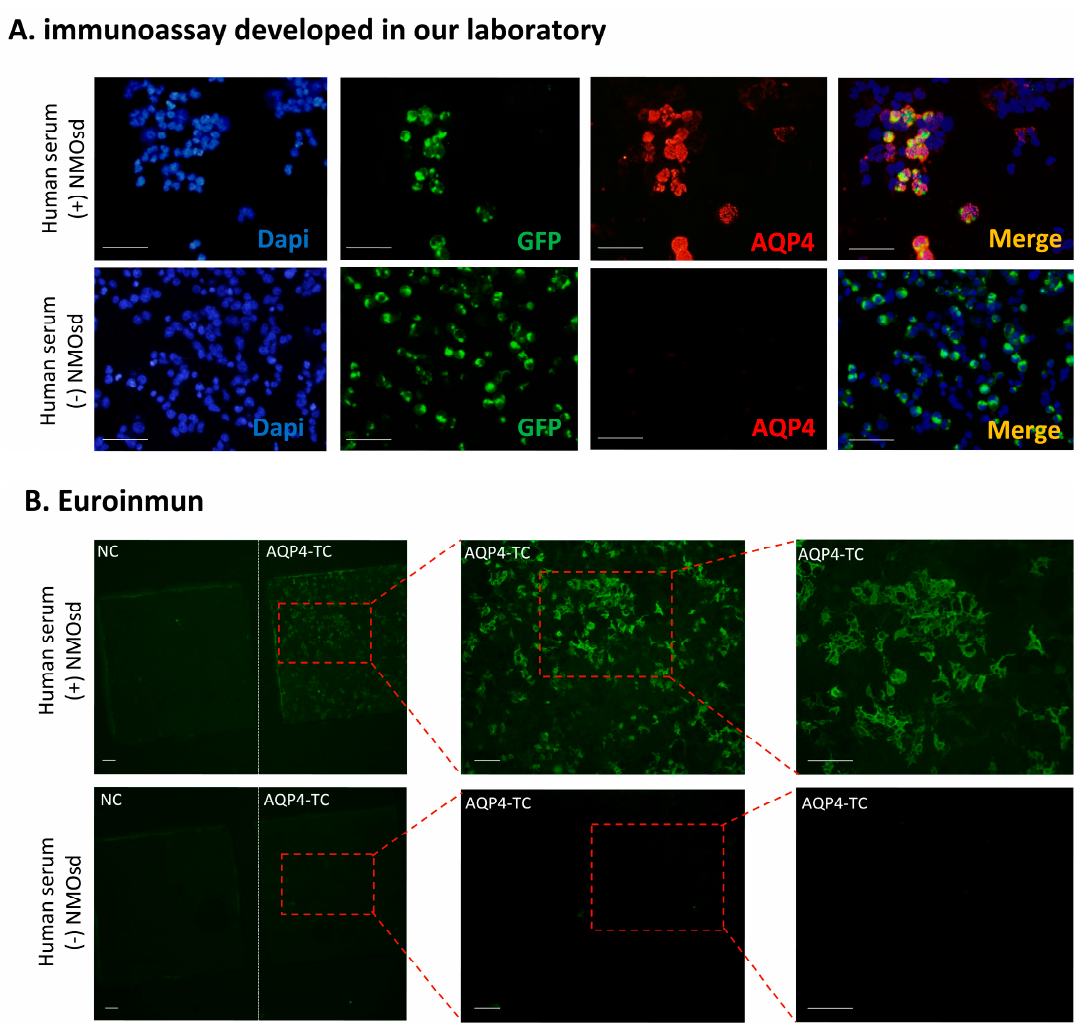
Figure 1. Immunofluorescence assay for the detection of anti-aquaporin-4 (AQP4) antibodies: ( A ), representative images of the immunofluorescence assay developed in our laboratory using cells expressing human AQP4 fused to green fluorescent protein (GFP) (hAQP4-EGFP) (green). The immune reaction produced by patient serums either from Neuromyelitis optica spectrum disorder ( + NMOsd) or not ( − NMOsd) over AQP4 expressing cells (red) revealed presence or absence of anti-AQP4 antibodies in analyzed serums. Nuclei were visualized with Dapi (blue) and the merged image of both fluorescent signals (anti-AQP4 antibodies and GFP) is shown in yellow. ( B ), representative images of the Euroimmun kit using patient serums either from Neuromyelitis optica spectrum disorder ( + NMOsd) or not ( − NMOsd) over either AQP4 expressing cells (AQP4-TC) or not AQP4 expressing cells (NC) as negative control. The images in both cases ( A , B ) were obtained using the sera from the same patients ( + NMOsd and –NMOsd). The immune reaction produced by NMOsd patient serums were visualized in green. Scale bar 100 µm.